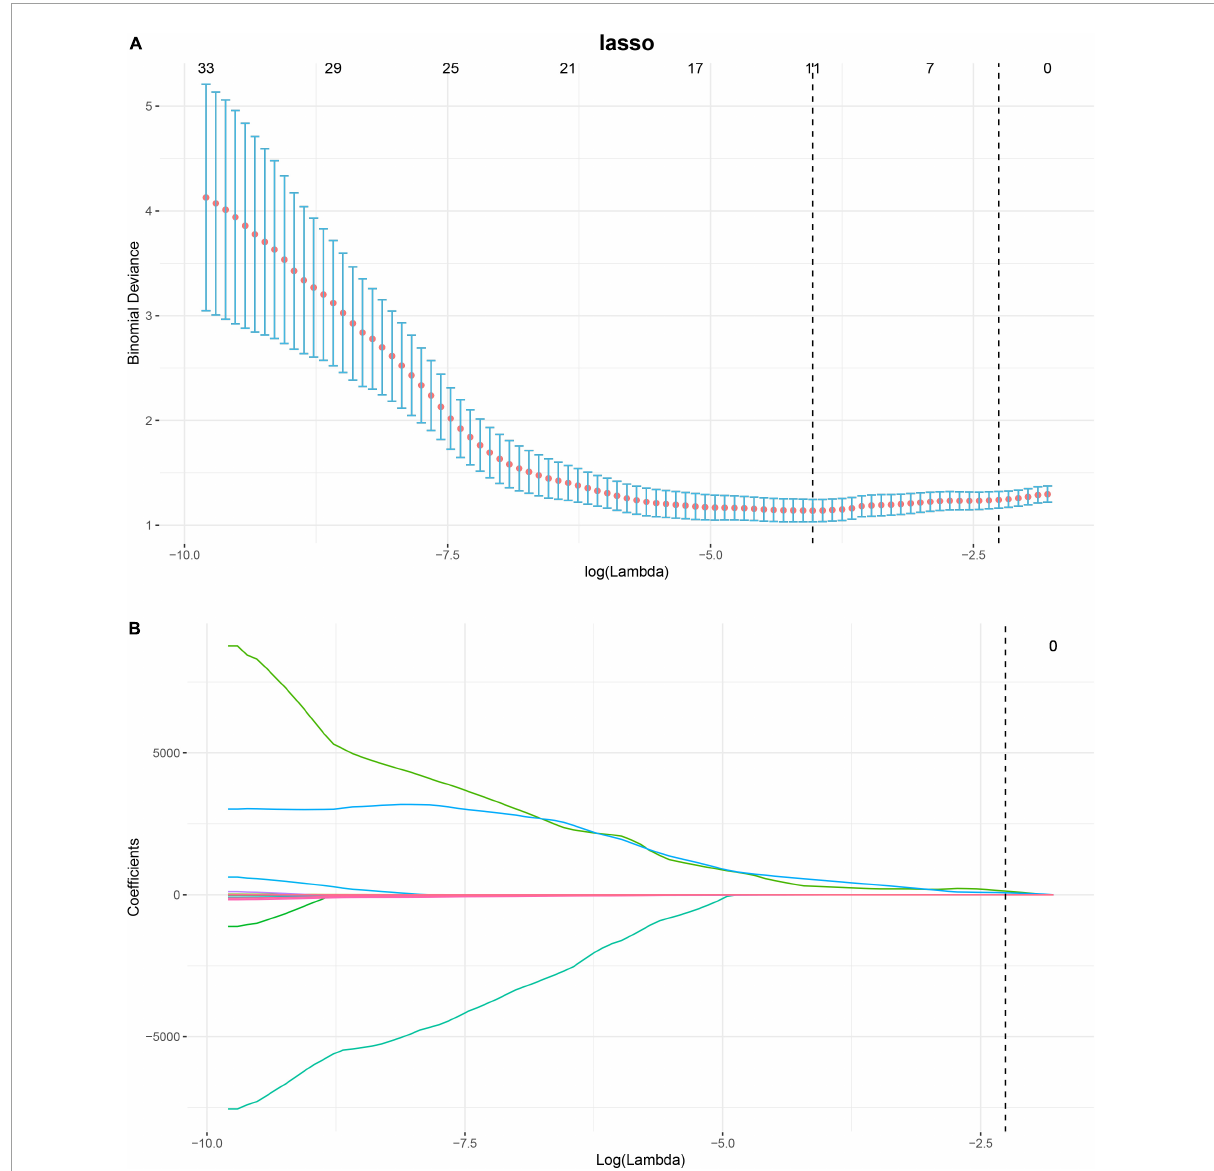
FIGURE3 Process of feature selection in patients with pre-eclampsia (PE) by binary least absolute shrinkage and selection operator (LASSO) logistic regression. In total, eleven non-zero coefficients (radiomics signature) with the highest curves (AUC) for predicting PE are selected (A) . The coefficients of each radiomics feature are plotted vs . log (lambda) (B) . AUC, area under curve; LASSO, least absolute shrinkage and selection